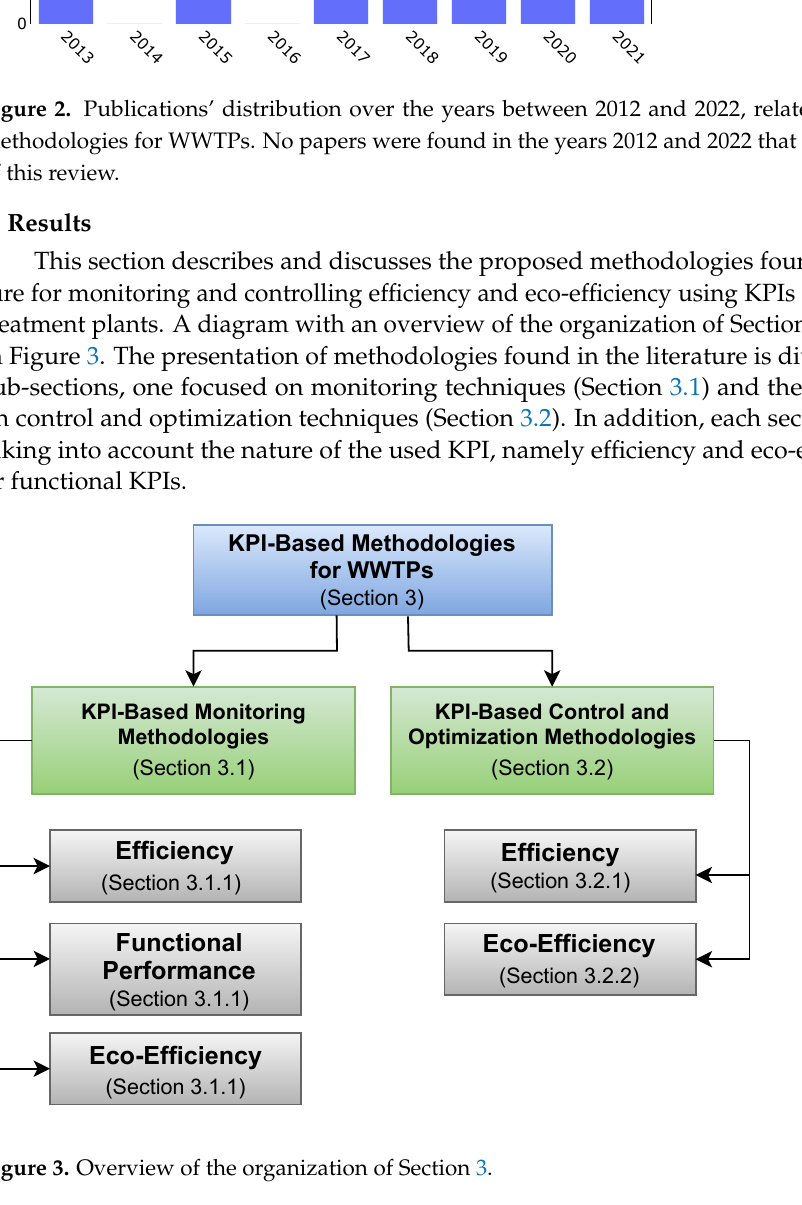
Figure 3. Overview of the organization of Section